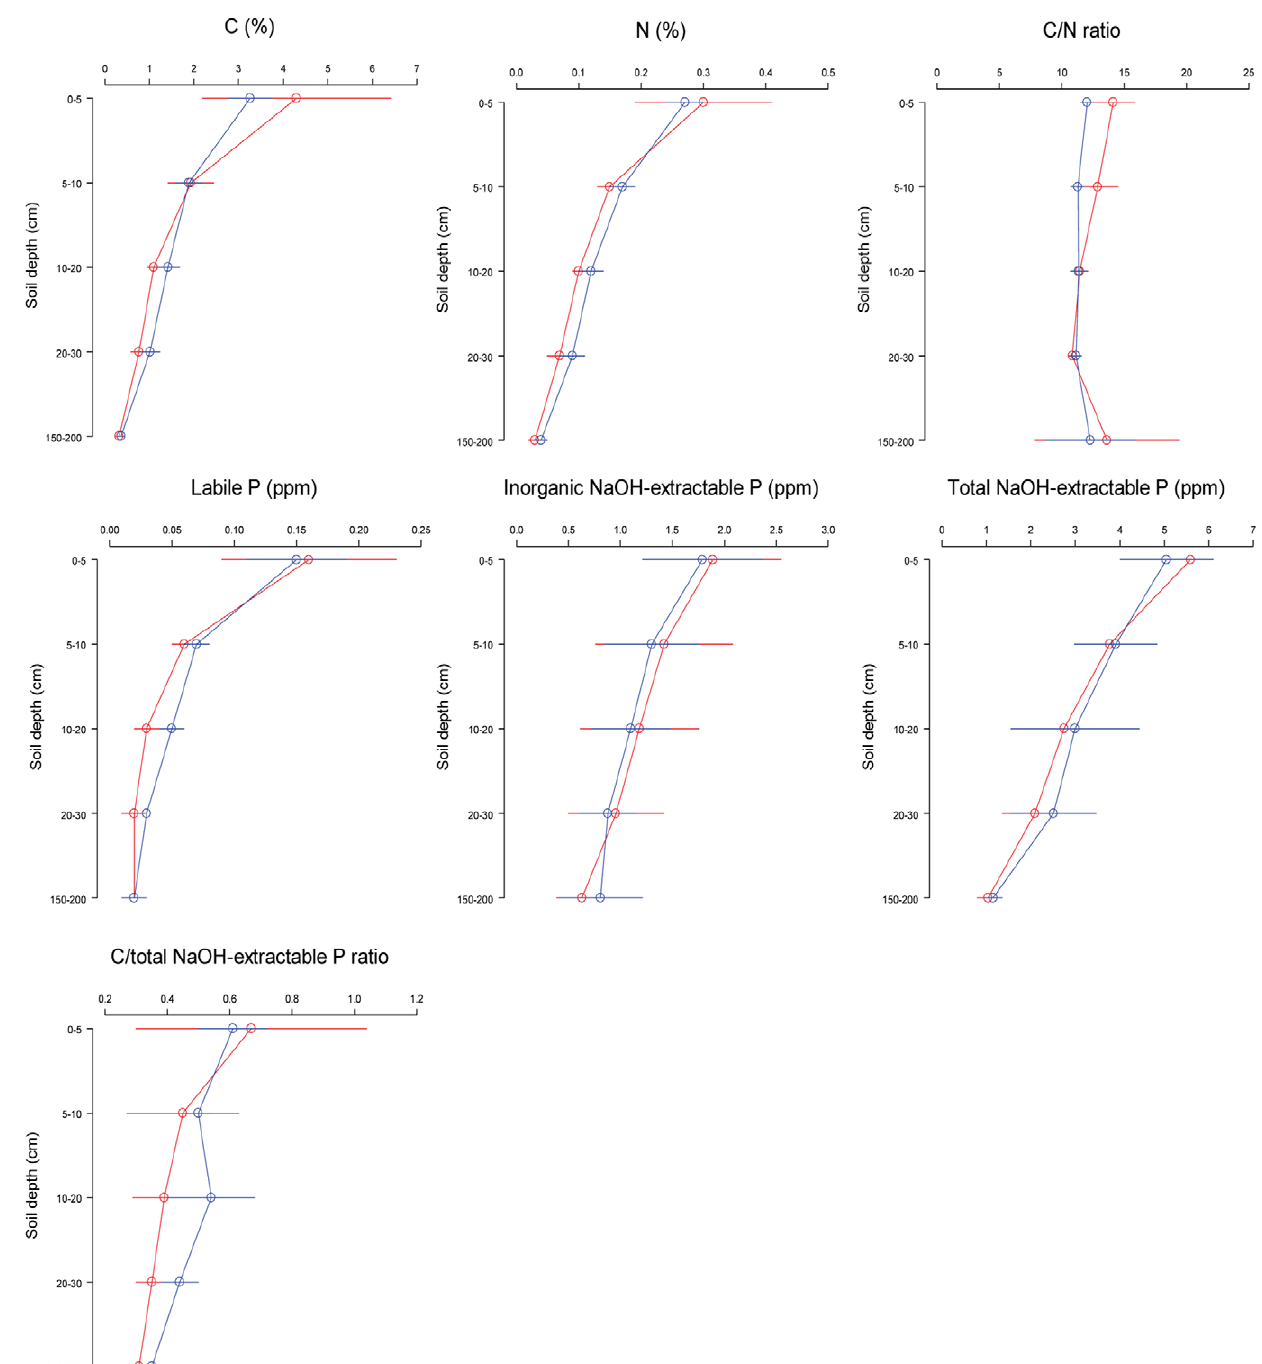
Figure 3. Comparison of the C content of soil organic residues (first row, left); N content of soil organic residues (first row, centre); C/N ratio (first row, right); labile P concentration (second row, left); inorganic NaOH-extractable P concentration (second row, centre); total NaOH-extractable P concentration (second row, right) and C:total NaOH-extractable P ratio (third row, left) found in soils at different depths sampled beneath stands of forest dominated the species Gilbertiodendron (red line) and adjacent higher- diversity forests where no species dominates (blue lines). Circles show mean values and error bars indicate 95% confidence intervals (n=3).